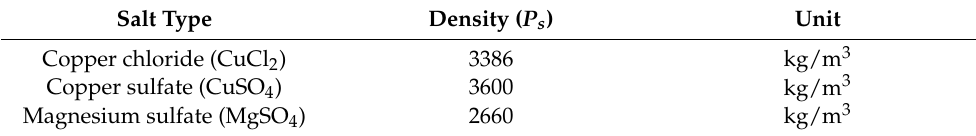
Table 3. Densities of the three